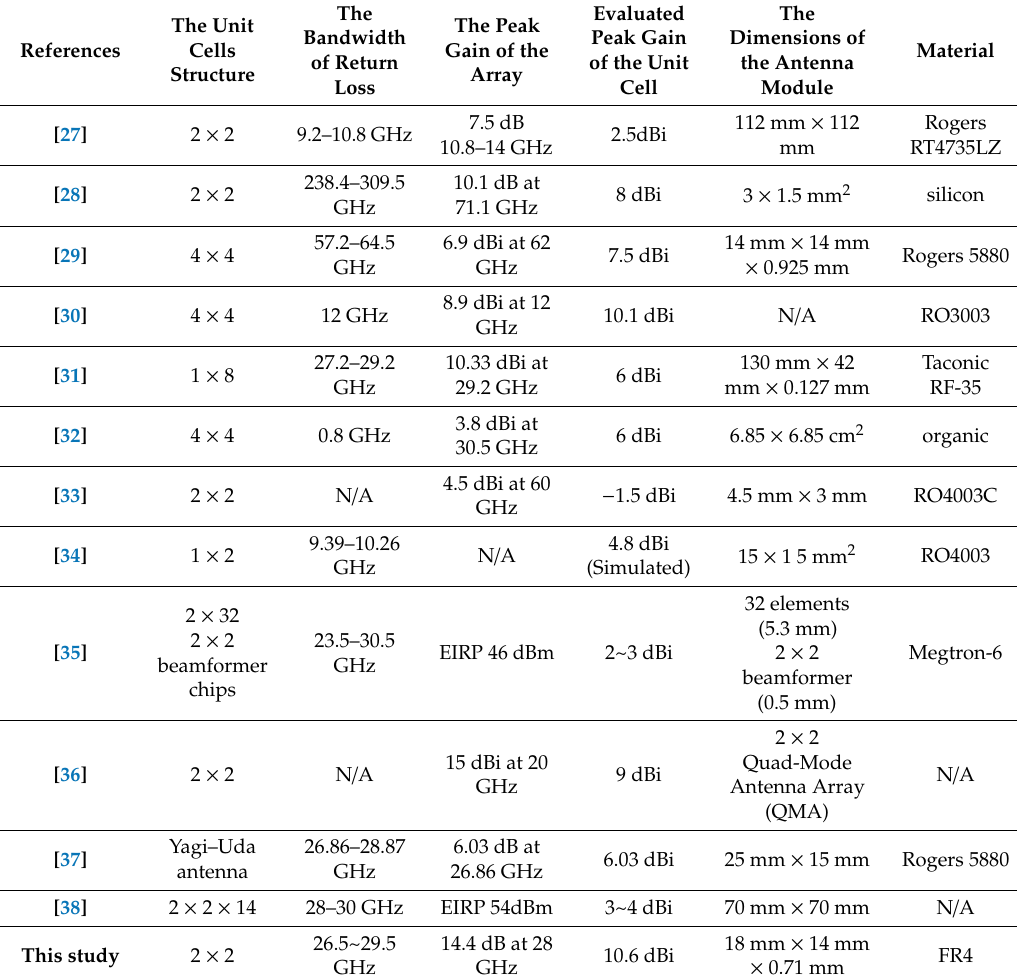
Table 2. Comparisons of antenna